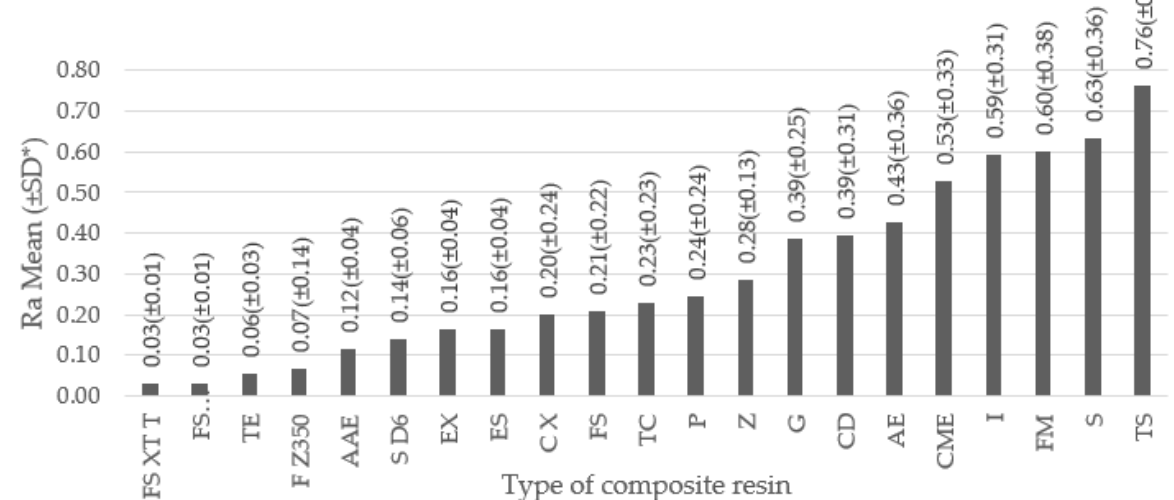
Figure 4. Surface roughness according to the composite resin used. The figure represents, on the X axis, the resin used and, on the Y axis, the surface roughness in Ra µ m. The height of each bar represents the mean of Ra ( ± SD) obtained according to each composite resin. * SD = Standard Deviation. List of abbreviations for type of composite resin: FS XT T (Filtek Supreme XT [transparent shade]), FS XT D (Filtek Supreme XT [dentin shade]), TE (Tetric EvoCeram), F Z350 (Filtek Z350), AAE (Aelite Aesthetic Enamel), S D6 (Synegy D6), EX (Evolu-X), ES (Estelite Sigma), C X (Ceram X), FS (Filtek Supreme), TC (Tetric Ceram), P (Premise), Z (Zenit), G (Grandio), CD (Charisma Diamond), AE (Aelite Enamel), CME (Clearfil Majesty Esthetic), I (Ice), FM (Fill Magic ® ), S (Smile), TS (TPH Spectrum ® ).